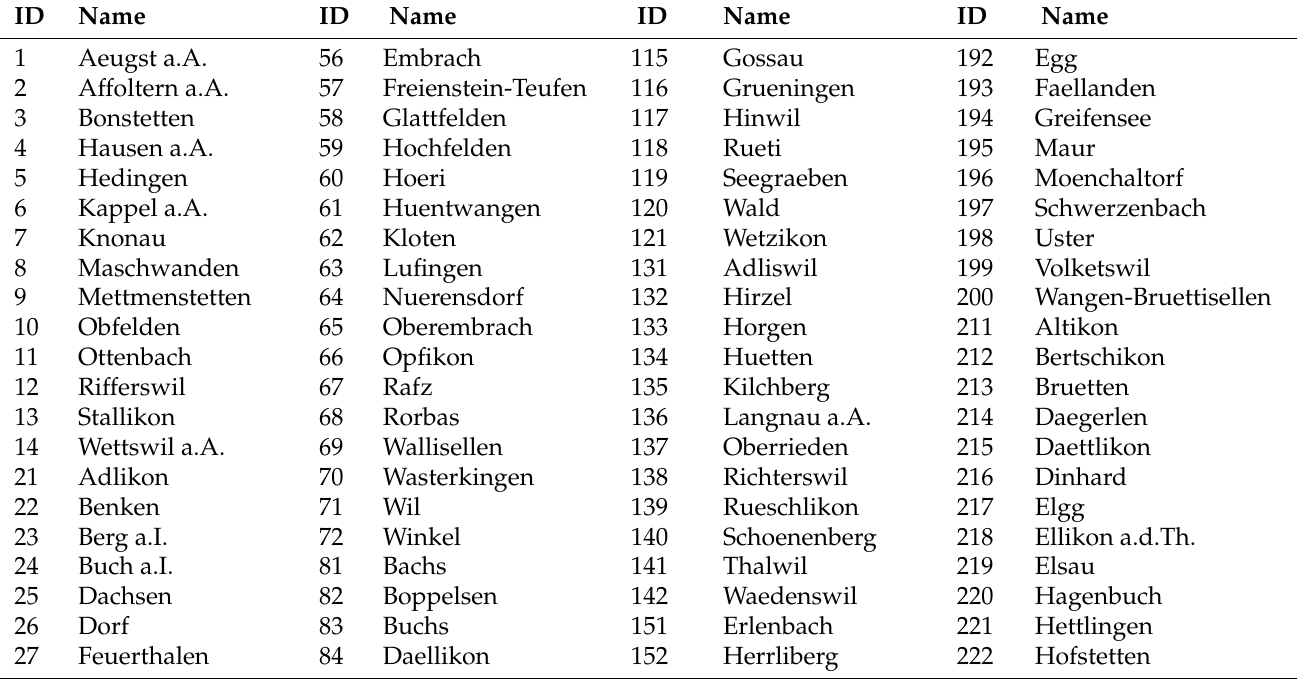
Table A2. Municipalities in the canton of Zurich. (This table lists all 171 municipalities in the canton of Zurich alphabetically. Moreover, a regional identifier ( ID ) is linked to each